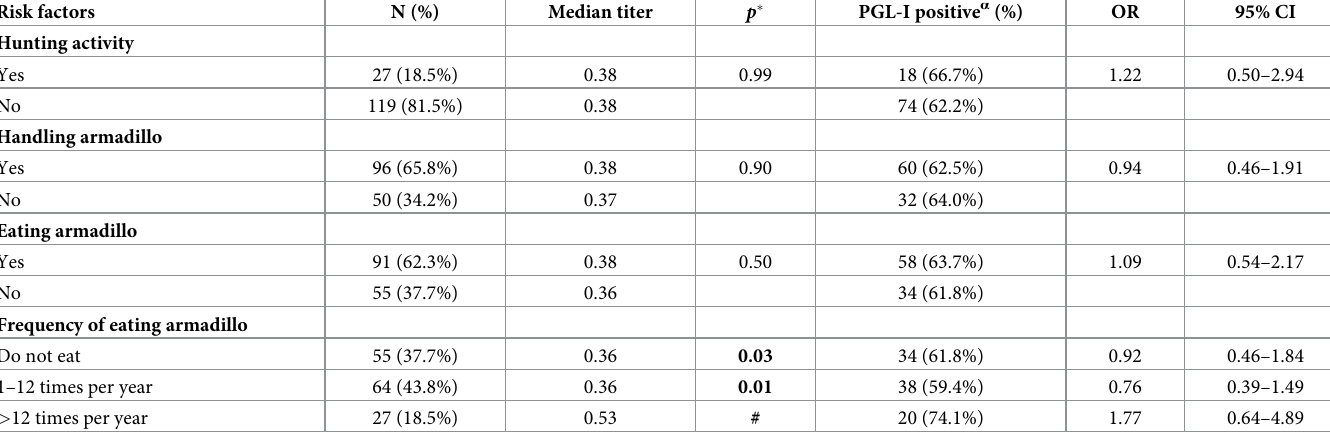
Table 2. Risk factors of behaviors associated with PGL-I titer in surveyed residents living in the municipality of Belterra,